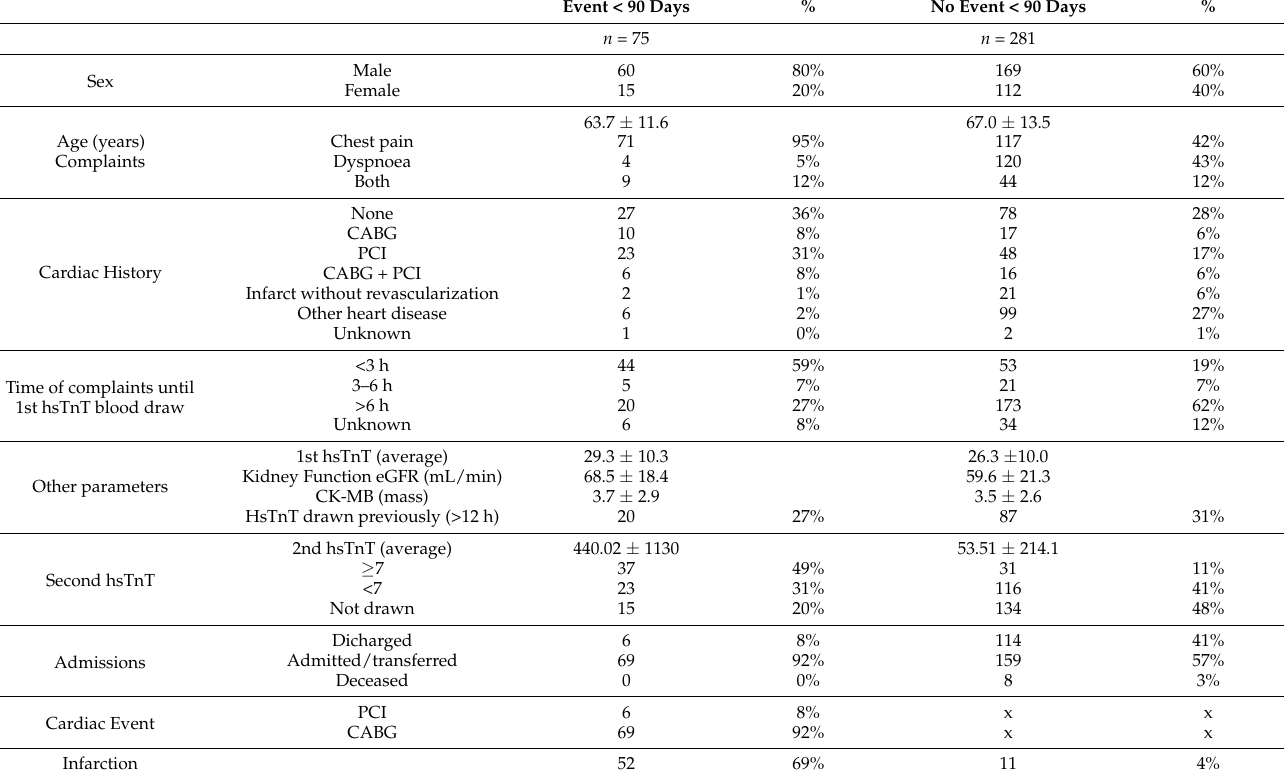
Table 1. Characteristics of the patient in the event and the no-event group. Event < 90